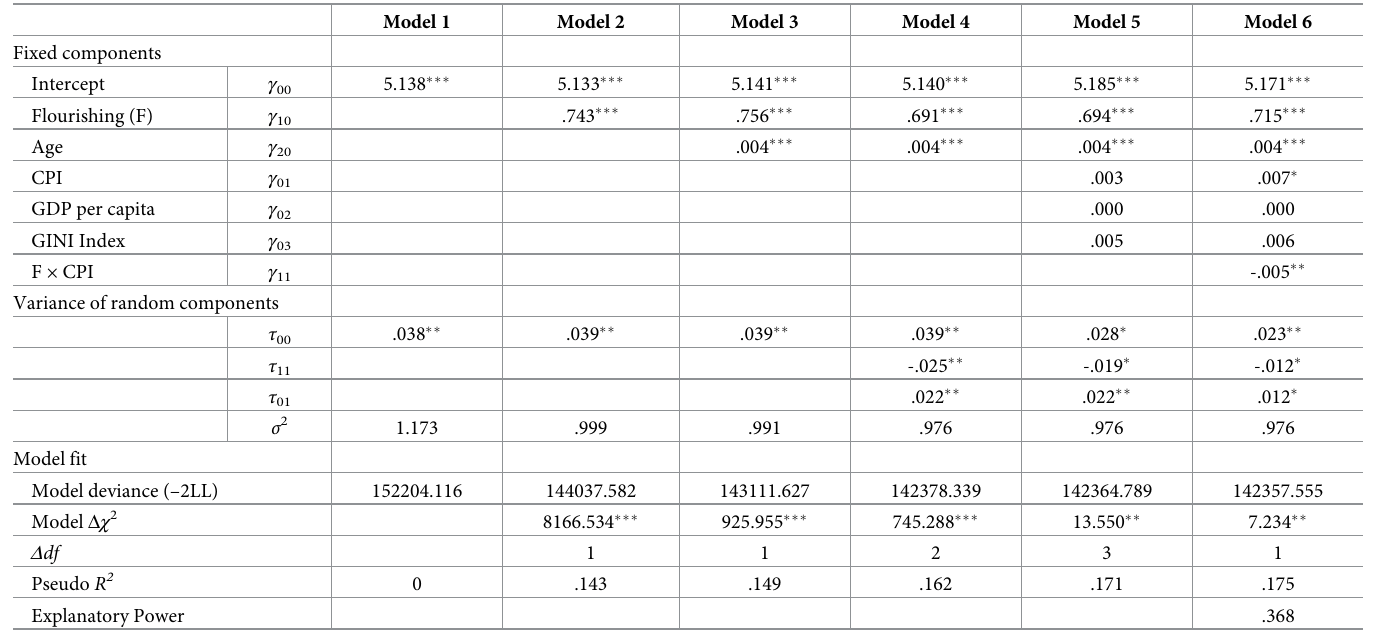
Table 6. Parameter estimates for the six models examining the relation of helping close others on flourishing and CPI in Study